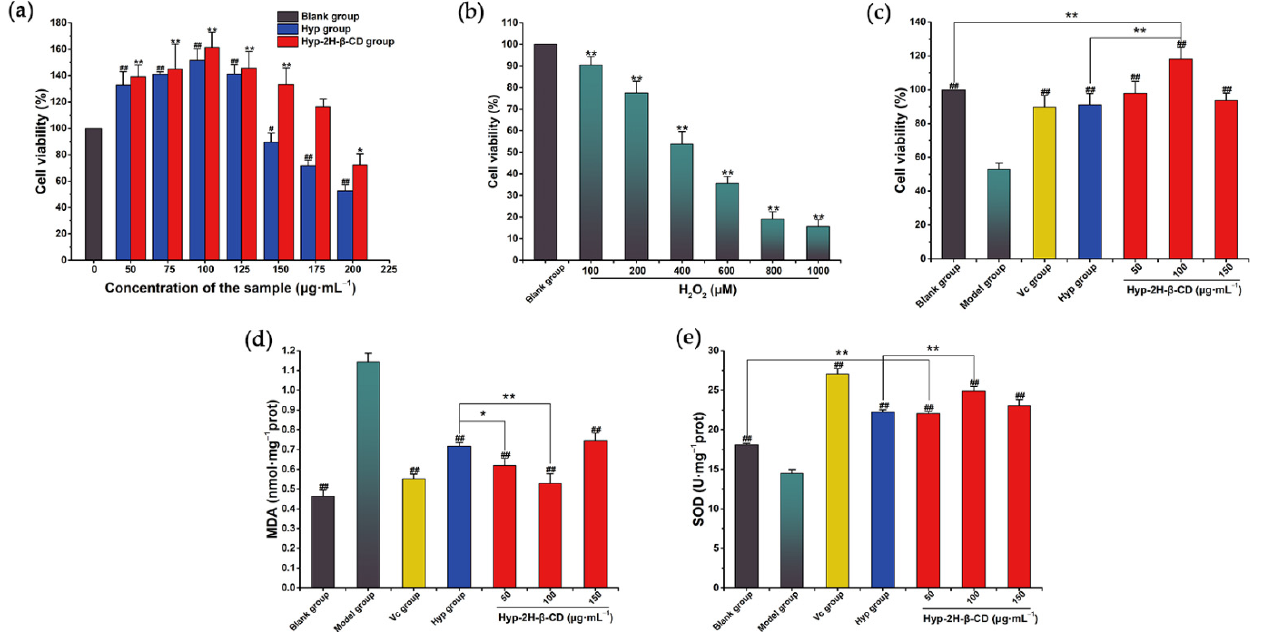
Figure 12. Results of the toxicity and antioxidant activity tests. ( a ) The effects of Hyp and Hyp – 2H- β -CD on the cell viability of RAW264.7 cells. ( b ) The effects of H 2 O 2 on RAW264.7 cells. ( c ) The protective effects of Hyp and Hyp – 2H- β -CD on H 2 O 2 – RAW264.7 cells. ( d ) The effects on MDA content of Hyp and Hyp – 2H- β -CD in the cells. ( e ) The effects on SOD content of Hyp and Hyp – 2H- β -CD in the cells. In ( c – e ), model group (H 2 O 2 , 500 μ M), L-ascorbic acid group (L-ascorbic acid, 100 μ g·mL − 1 ), Hyp group (Hyp, 100 μ g·mL − 1 ), and Hyp – 2H- β -CD group (50, 100, 150 μ g·mL − 1 ). Note: In ( a , b ), compared to the blank group, * indicates evident distinction at p < 0.05, ** shows very evident distinction at p < 0.01, # indicates significant difference at p < 0.05, and ## shows very evident distinction at p < 0.01. In ( c – e ), for the comparison between the two groups, * indicates evident distinction at p < 0.05, ** indicates extremely evident distinction at p < 0.01; compared to the model group, ## indicates extremely evident distinction at p < 0.01.